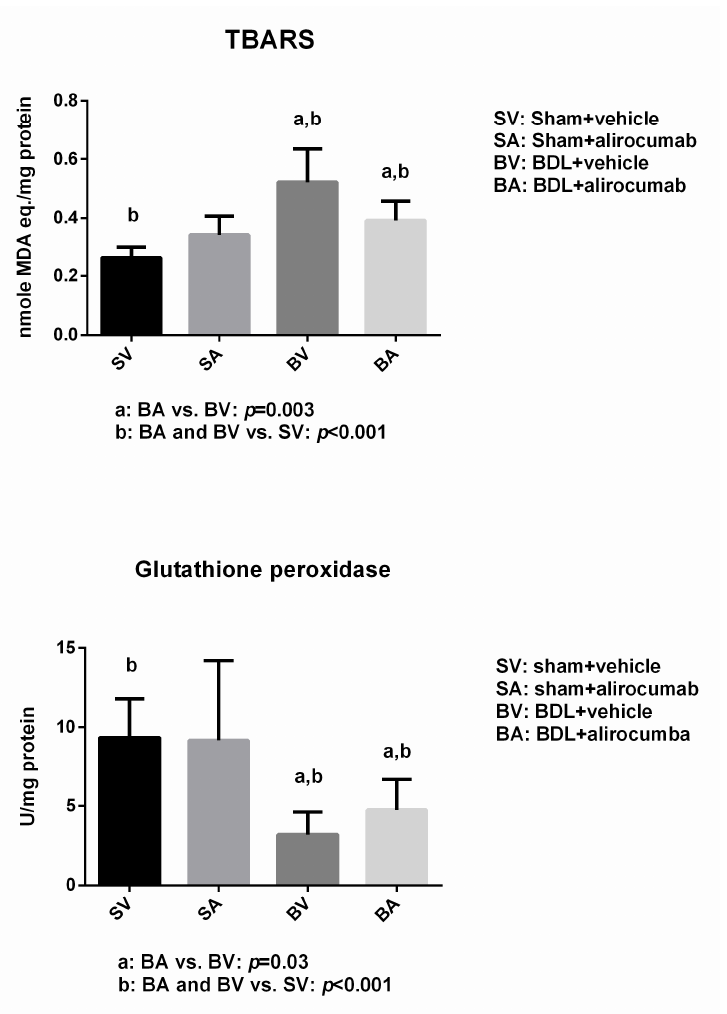
Figure 4. Oxidative stress in sham and BDL rats with or without alirocumab treatment. Up-regulation of the oxidative stress marker, thiobarbituric acid reactive substances (TBARS) activity (Sham-V vs. Sham-A vs. BDL-V vs. BDL-A: n = 8:12:11:12; BDL-A vs. BDL-V, p = 0.003, BDL-A and BDL-V vs. Sham-V, p < 0.001), and down-regulation of anti-oxidative stress marker, glutathione peroxidase activity (BDL-A vs. BDL-V, p = 0.03, BDL-A and BDL-V vs. Sham-V, p < 0.001) were noted in BDL rats compared to sham rats. Alirocumab significantly reduced TBARS and elevated glutathione peroxidase activities in BDL rats.